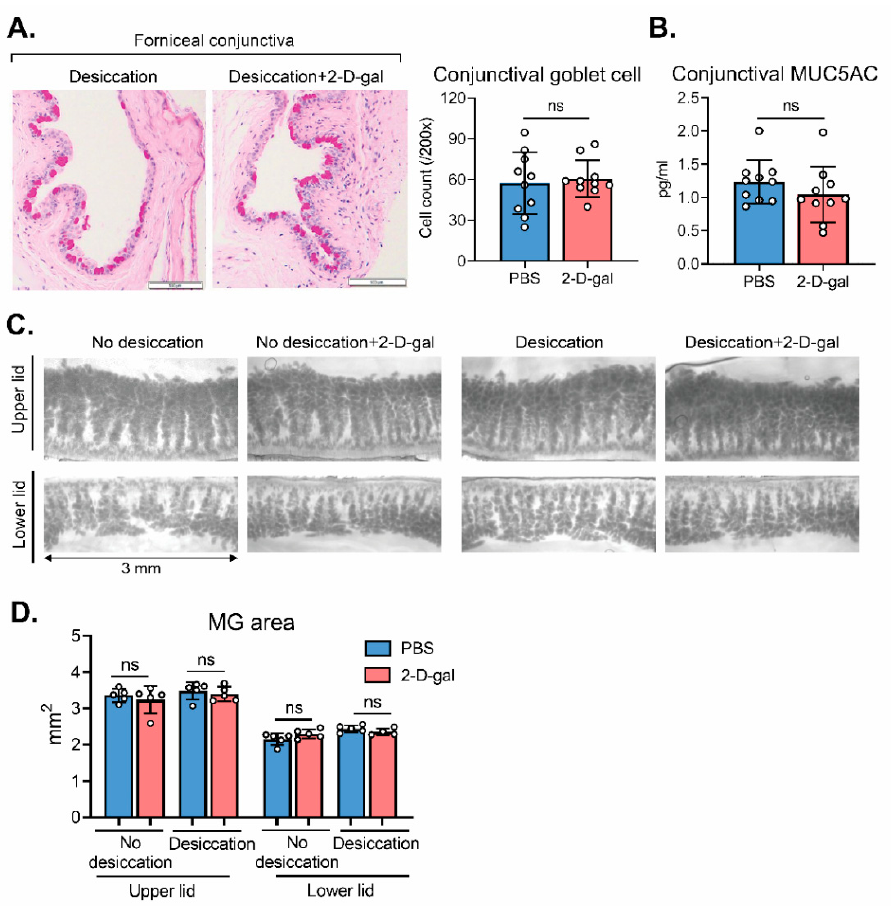
Figure 4. Effects of 2-D-gal on conjunctival goblet cell and meibomian gland of the eyelid. ( A ) Representative images of periodic acid–Schiff (PAS) staining of the inferior conjunctival fornix (sagittal section; scale bar: 100 µ m) and quantification of PAS-stained goblet cell counts in BALB/c mice under desiccating stress with or without 2-D-gal treatment. ( B ) ELISA for conjunctival MUC5AC. ( C ) Representative transillumination meibography images. ( D ) Quantification of the meibomian gland area of the upper and lower eyelids. A circle depicts data (mean ± SD) from a single individual animal. ns: not significant.